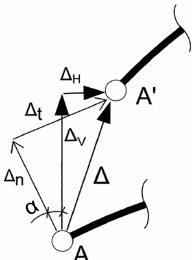
Figure 5. Support displacement in the case of a flexible T-stub